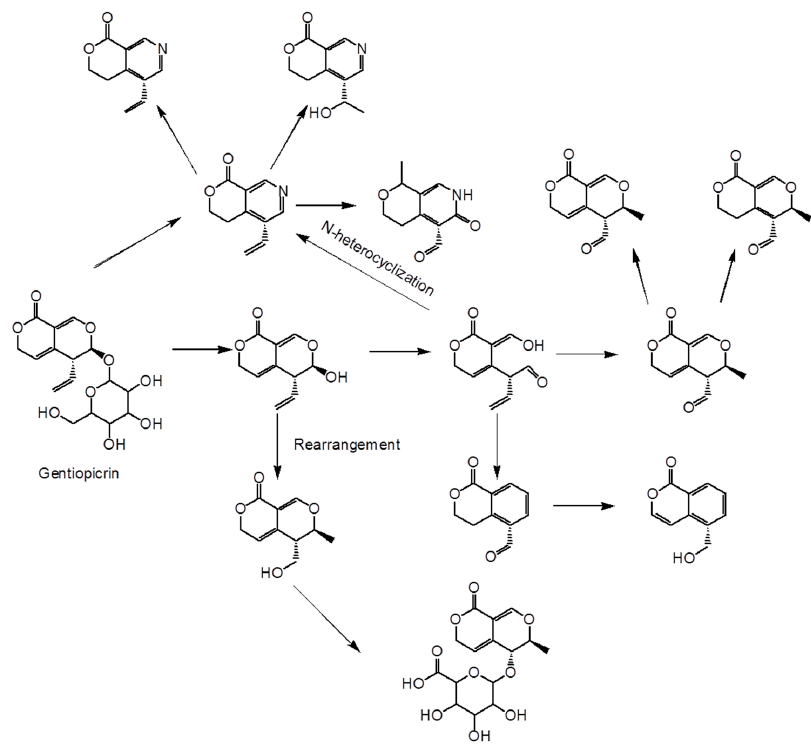
Figure 8. The metabolic processes of gentiopicrin.